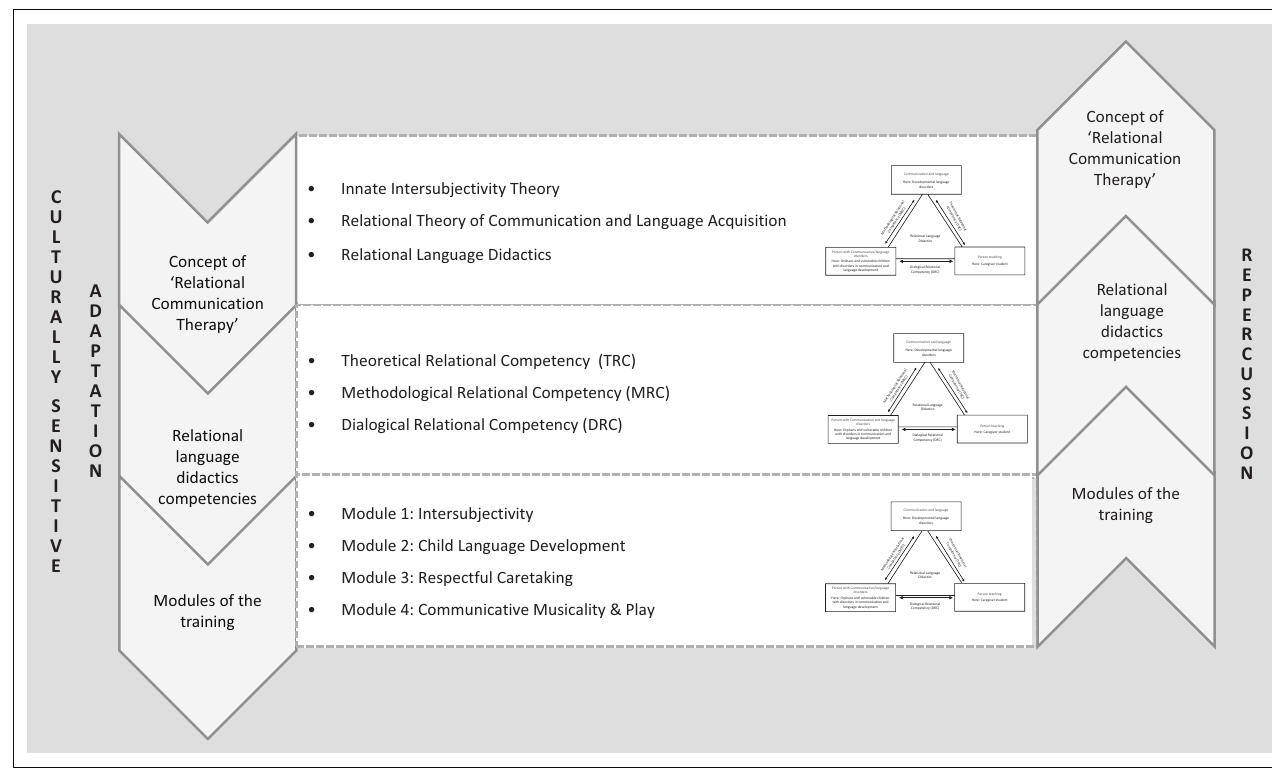
FIGURE 2: Interacting theoretical